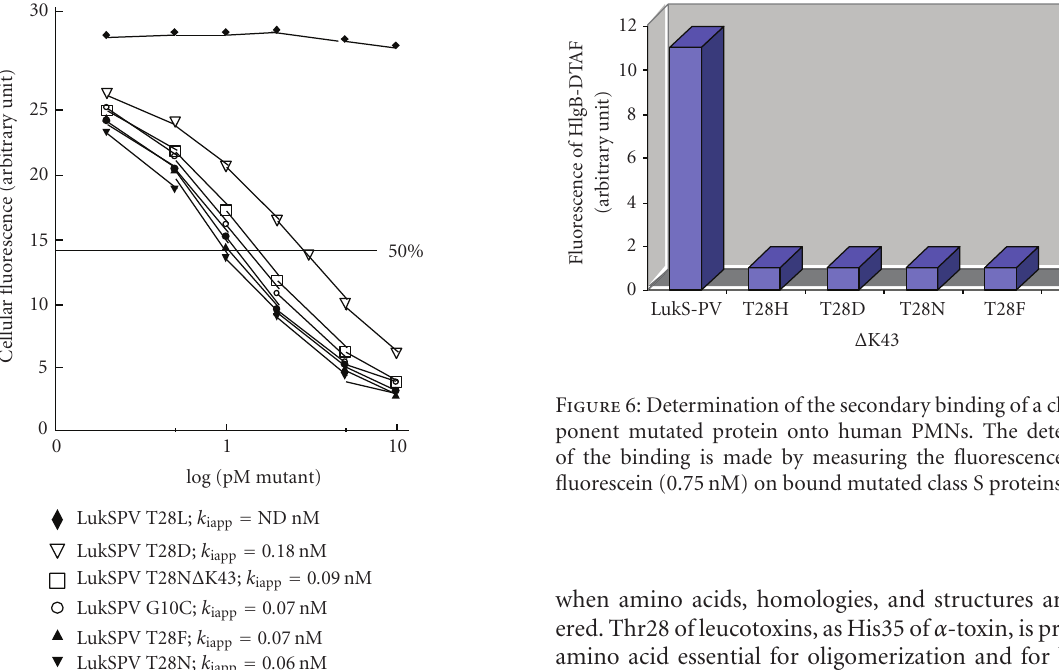
when amino acids, homologies, and structures are consid- ered. Thr28 of leucotoxins, as His35 of α -toxin, is probably